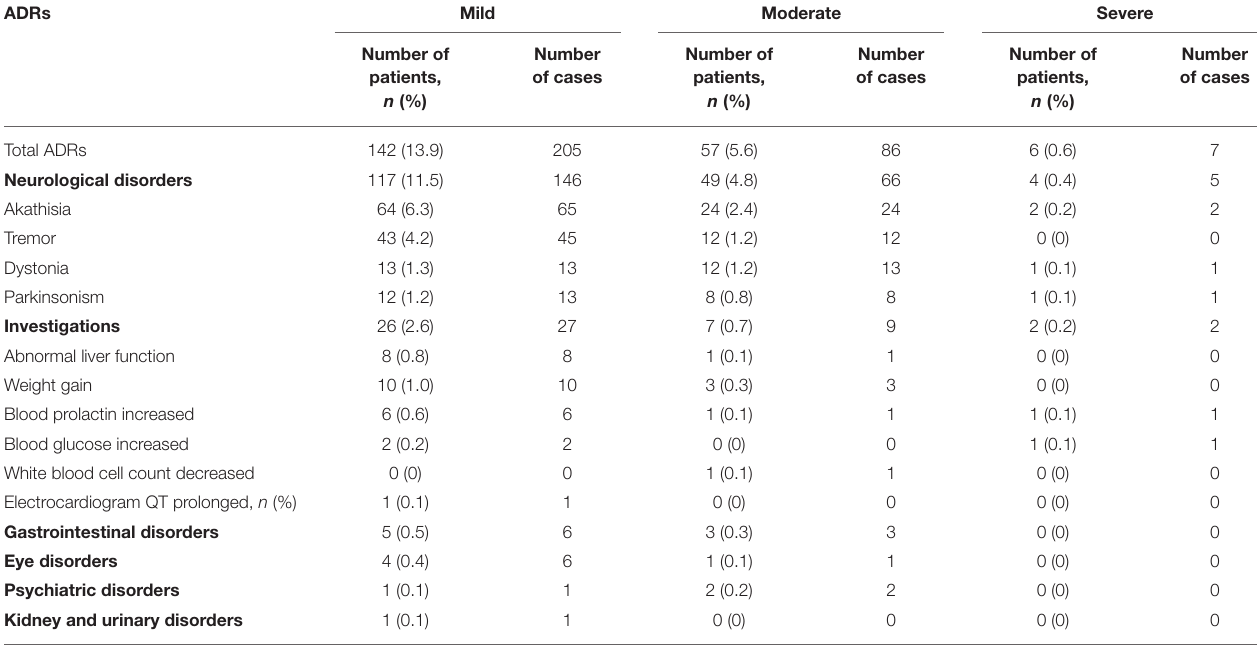
TABLE 2 | ADRs involve systematic and clinical manifestations.